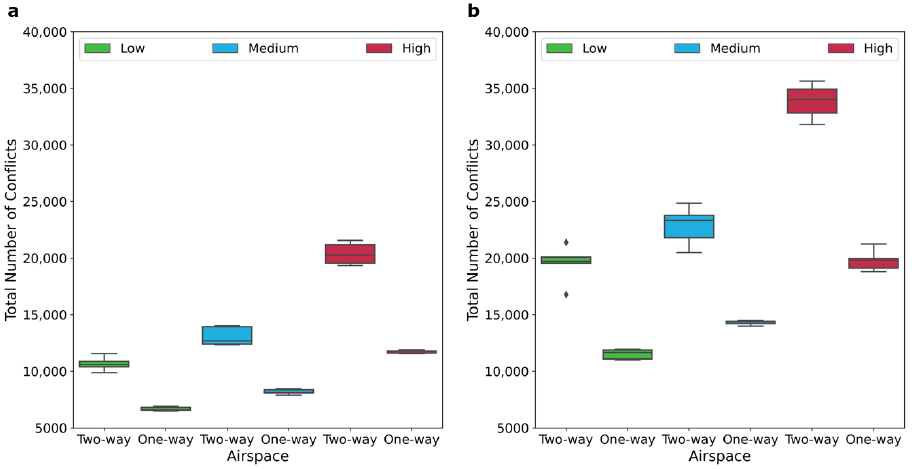
Figure 7. The total number of pairwise conflicts for the two-way and one-way urban airspace concept for low, medium, and high traffic demands. ( a ) Without conflict resolution. ( b ) With conflict